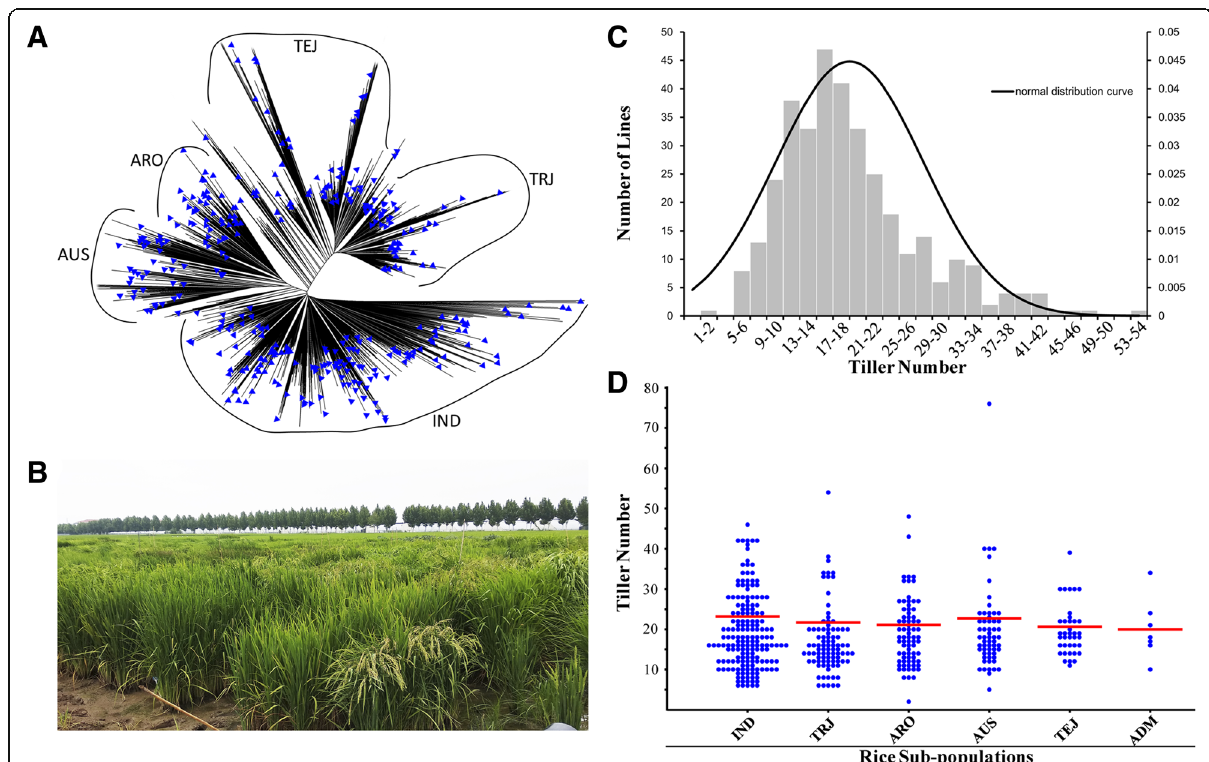
Fig. 1 The structure of the S-RDP-II population and its TN variation in the field. a Phylogenetic tree of the RDP-II population in which the 350 accessions (S-RDP-II) are indicated by blue triangles. Six subpopulations are IND, TEJ, TRJ, AUS, ARO and ADM. b Photo of S-RDP-II cultivars in the field when TN was counted. c The TN variation distribution in the S-RDP-II population. X-axis represents TNs and Y-axis represents the number of accessions with the TN interval. d The TN variation in the subpopulations. Each dot represents a rice accession in the subpopulation. Red line represents the average value of TNs in the six